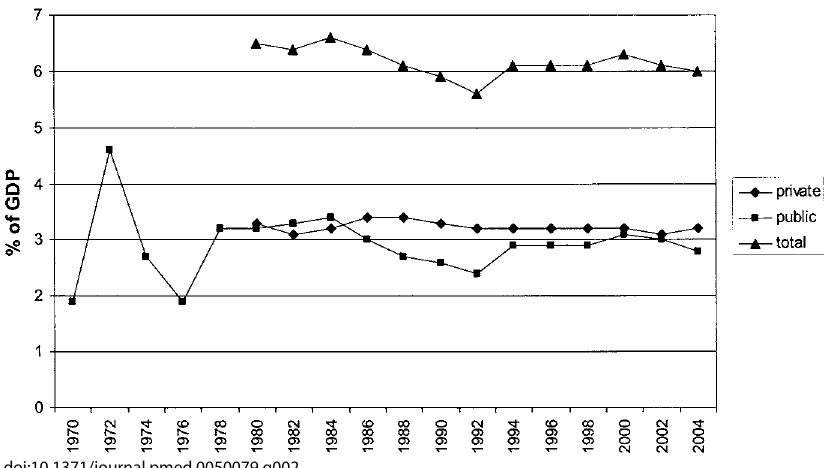
Figure 2. Health Expenditure in Chile, 1970–2004, as a Percentage of Gross Domestic Product As a percentage of gross domestic product, public health expenditure rose under the Allende government, then decreased sharply under the Pinochet neoliberal experiment, and is now stable at around 3%. From